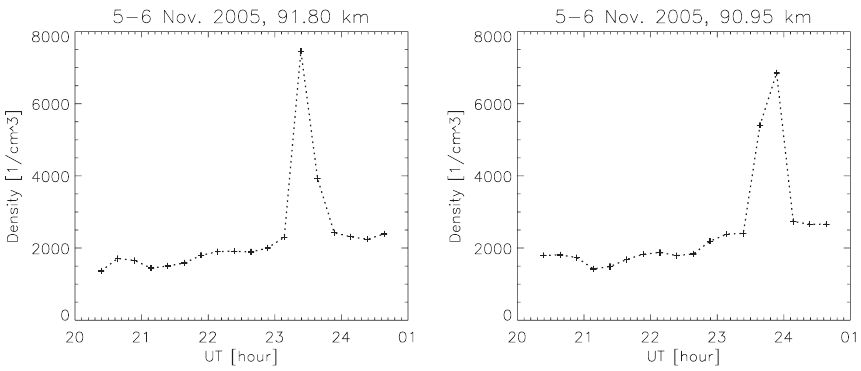
Fig. 2. 15min averaged densities from the ALOMAR Weber Na lidar on 5–6 November 2005 at the height of maximum density increase. Beam 1 (left) is pointing 20 ◦ W of zenith. Beam 2 (right) is pointing 20 ◦ E of